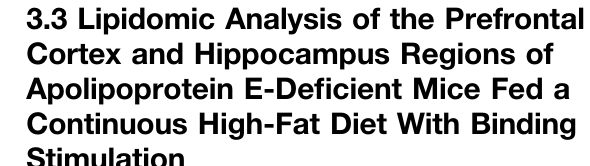
Frontiers in Molecular Biosciences |